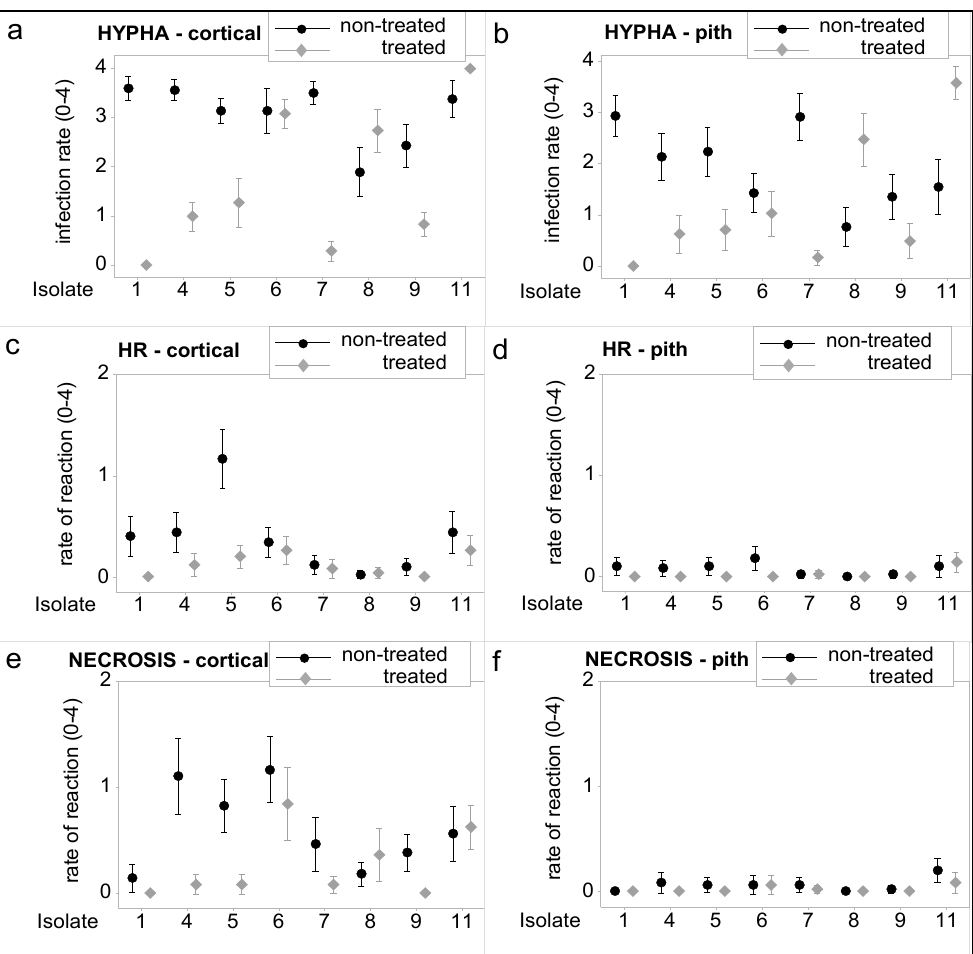
Figure 3. Occurrence of pathogen hyphae ( a , b ) and host reactions such as hypersensitive reaction ( c , d ) and necrosis ( e , f ) in the cortical and pith parenchyma of mefenoxam-treated and non-treated sunflower plants inoculated with Plasmopara halstedii . Treatment: non-treated and treated with mefenoxam (3 mg/kg seed). Isolate: code of Plasmopara halstedii isolates used in the experiment (1, 4, 5, 6, 7, 8, 9, and 11) (for more details, see Table 1). The infection rate and the rate of the host reaction were measured on a 0–4 scale. Vertical lines represent 95% confidence intervals (95% CI) of the mean values of disease rates and heights.